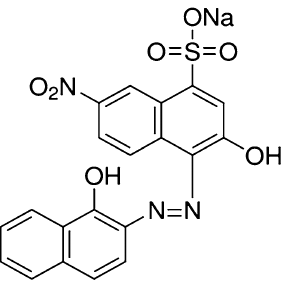
Fig. 2 Structure of Eriochrome black T (EBT)